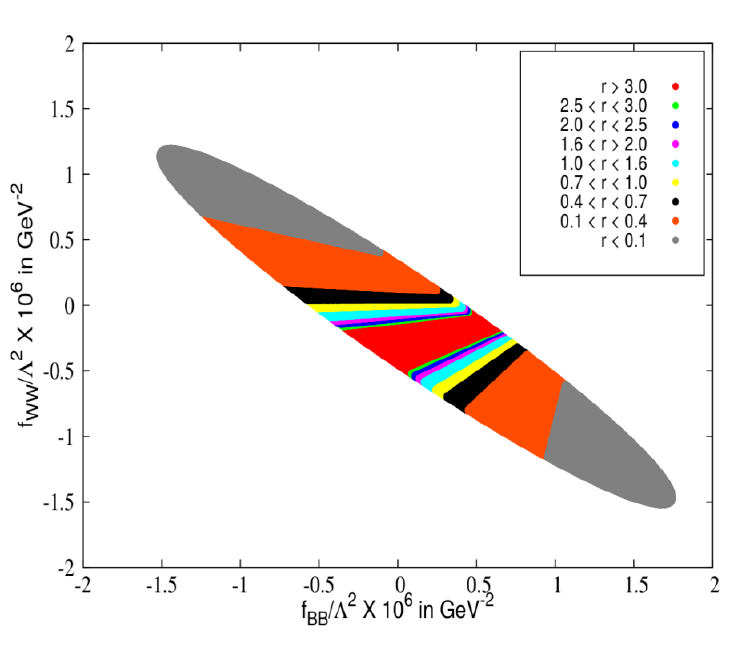
Figure 19 . The ratio r in f BB - f WW plane for triplet case. The ellipse denotes the region allowed at 2 (cid:27)